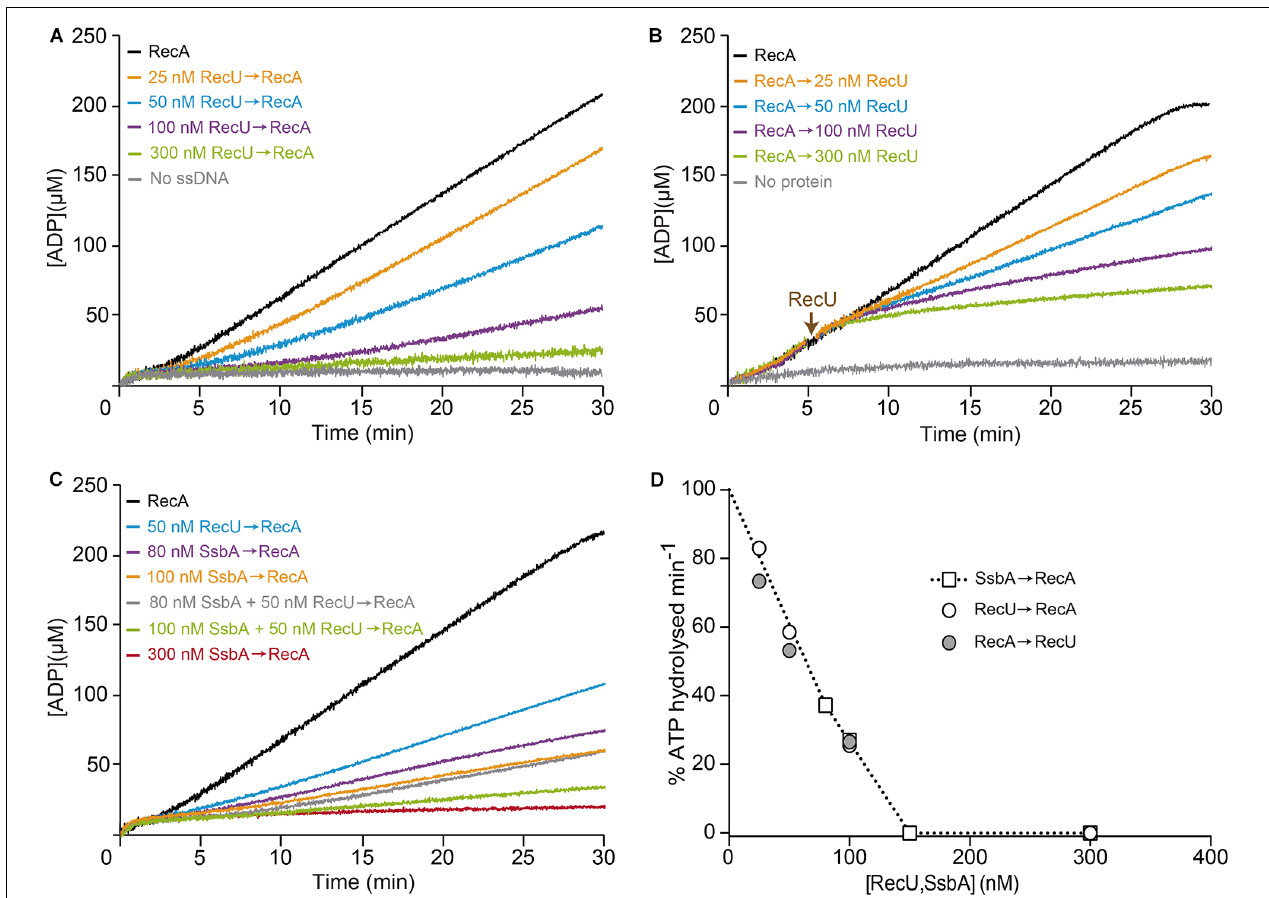
FIGURE 2 | Effect of RecU on RecA nucleation on ssDNA and filament growth. (A) Circular 3,199-nt ssDNA (10 µ M) was preincubated with increasing RecU concentrations (5 min, 37 ◦ C) in buffer B containing 5 mM ATP. RecA was added and ATPase activity was measured (30 min, 37 ◦ C). (B) ssDNA was preincubated with RecA (0.8 µ M; 5 min, 37 ◦ C), followed by increasing RecU concentrations, and ATPase activity was measured. (C) ssDNA was preincubated with increasing SsbA concentrations and/or a fixed amount of RecU (5 min, 37 ◦ C), followed by RecA, and ATPase activity was measured. The amount of ATP hydrolyzed was calculated as described (see Materials and Methods). The + symbol indicates that proteins were preincubated, and the arrow indicates the order of protein addition. Representative graphics are shown here, and quantification of the results is expressed as the mean ± SEM of > 3 independent experiments (see Table 2 ). (D) Comparison of the inhibitory effect of RecU and SsbA in RecA filament formation using the kinetic assays of A - C (see Table 2